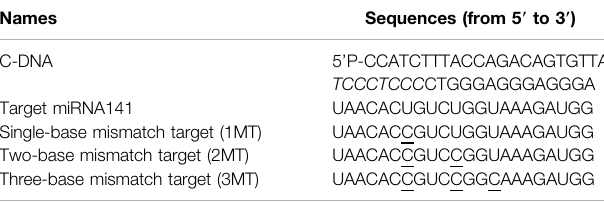
TABLE 1 | All DNA and miRNA sequences used in the work (from 5 ′ to 3 ′